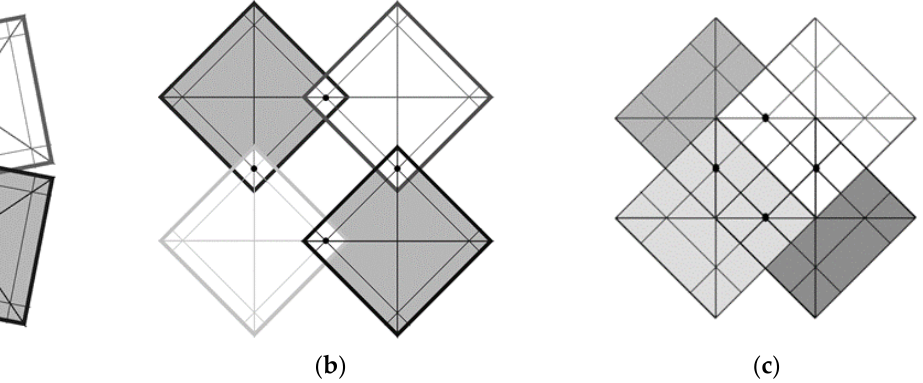
Figure 6. Auxetic structure 2 × 2 in partially open ( a ) and open positions ( b ) for x = 0.11, 𝜃